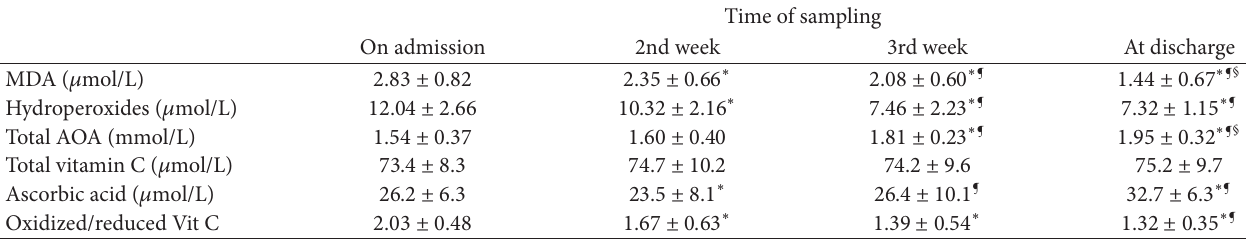
Table 2: Sequential changes and analysis of oxidative stress markers and vitamin C status during clinical treatment of acute bacterial osteomyelitis.